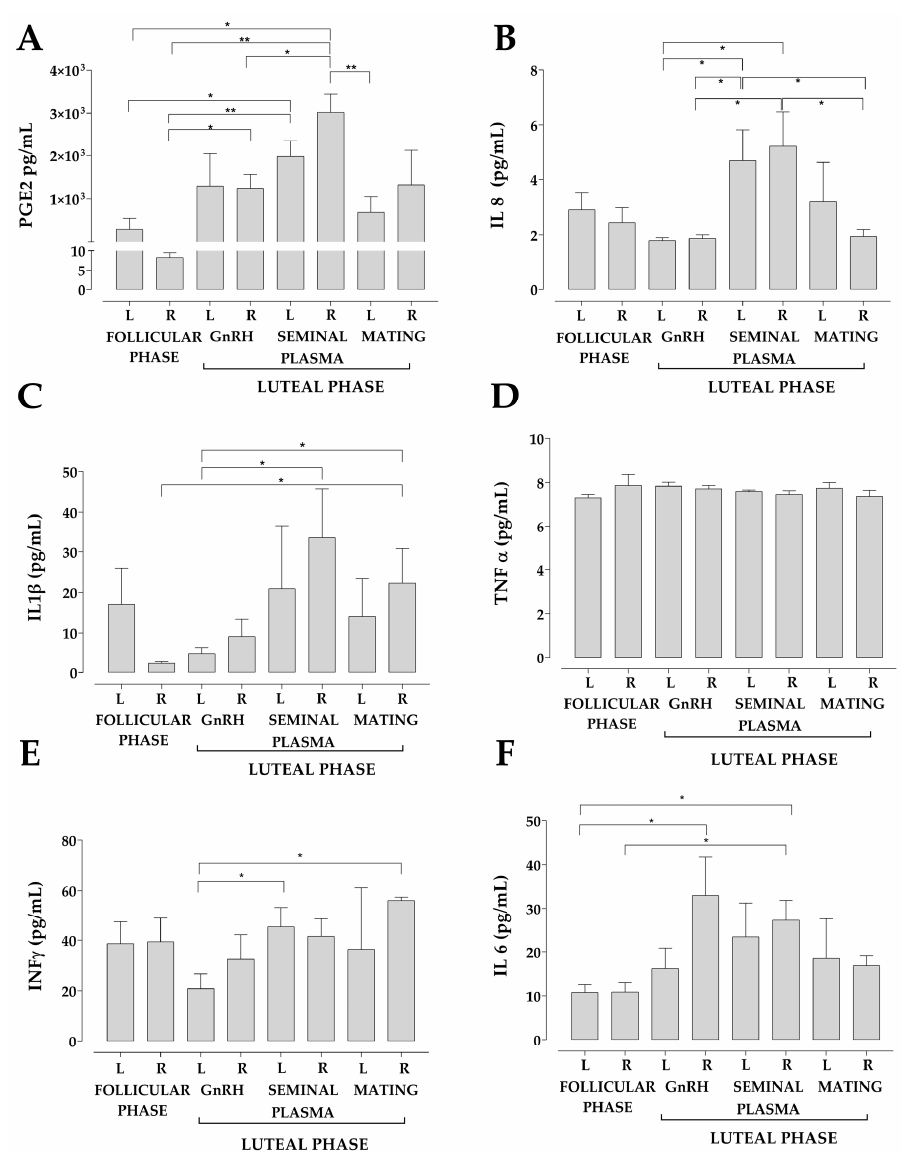
Figure 4. The concentration of PGE2, IL-8, IL-1 β , INF γ and IL-6 varied significantly between the left and the right uterine horn of some study groups. Representative bar graph of the concentration of PGE2 ( A ), IL-8 ( B ), IL-1 β ( C ), TNF- α ( D ), INF γ ( E ) and IL-6 ( F ). Concentration of inflammatory markers was measured using ELISA test in triplicate of at least five independent experiments. Each bar represents the mean ± SEM. L = left; R = right. * p < 0.05; ** p < 0.01.